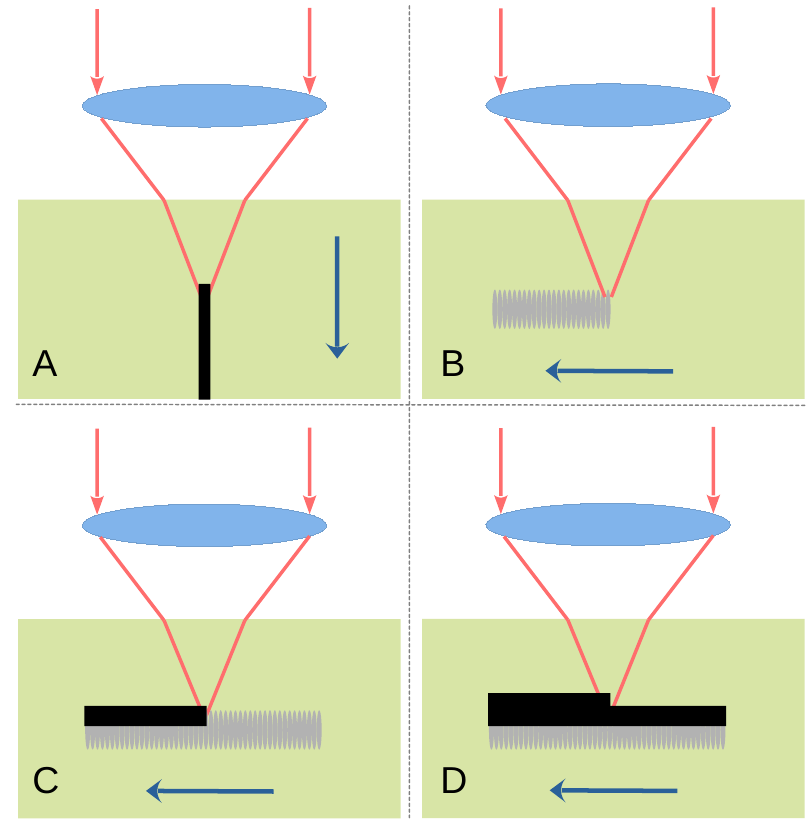
Figure 1. ( A ) Principal scheme of customary laser scanning parallel to the laser beam. ( B – D ) The stages of the proposed writing routine with scanning perpendicular to the laser beam: ( B ) seed creation; ( C ) the first graphitization scan; ( D ) the n-th grapitization